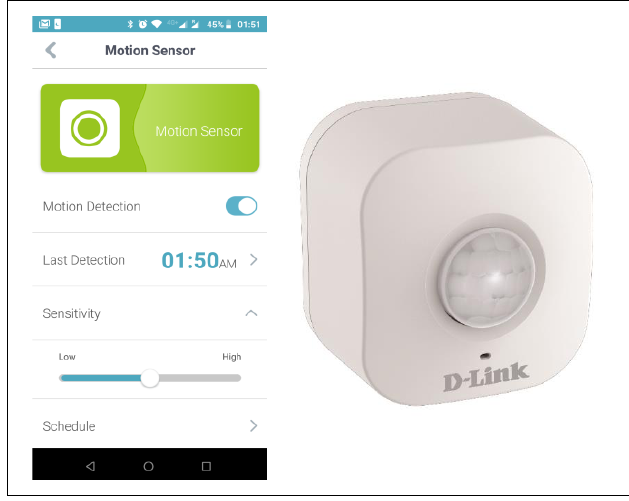
Fig. 3. The “myDLink Home” mobile app at the left (Android version) and the myDLink Wi-Fi Motion Sensor (DCH-S150) at the right.